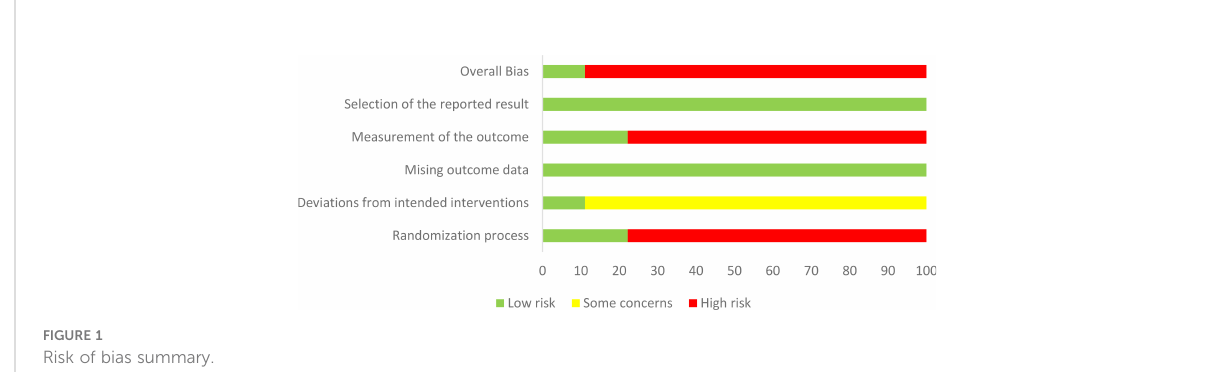
FIGURE 1 Risk of bias